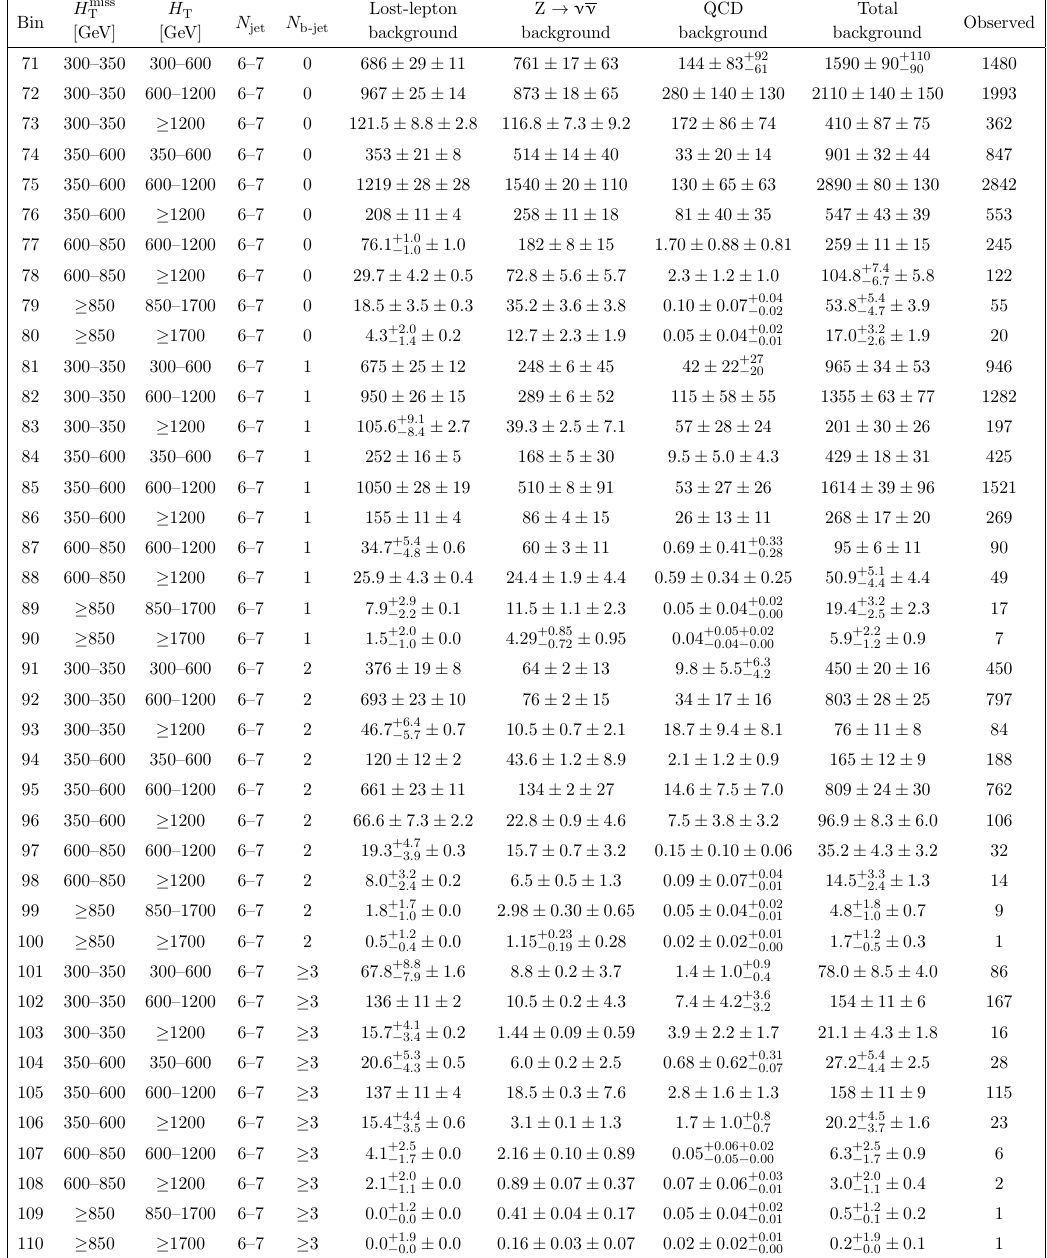
Table 5 . Observed number of events and pre-(cid:12)t background predictions in the 6 (cid:20) N bins. For the background predictions, the (cid:12)rst uncertainty is statistical and the second